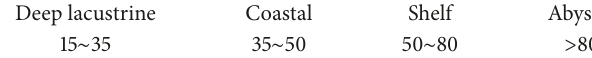
Table 6: The estimated paleobathymetry according to the sedimentary facies characteristics. Facies